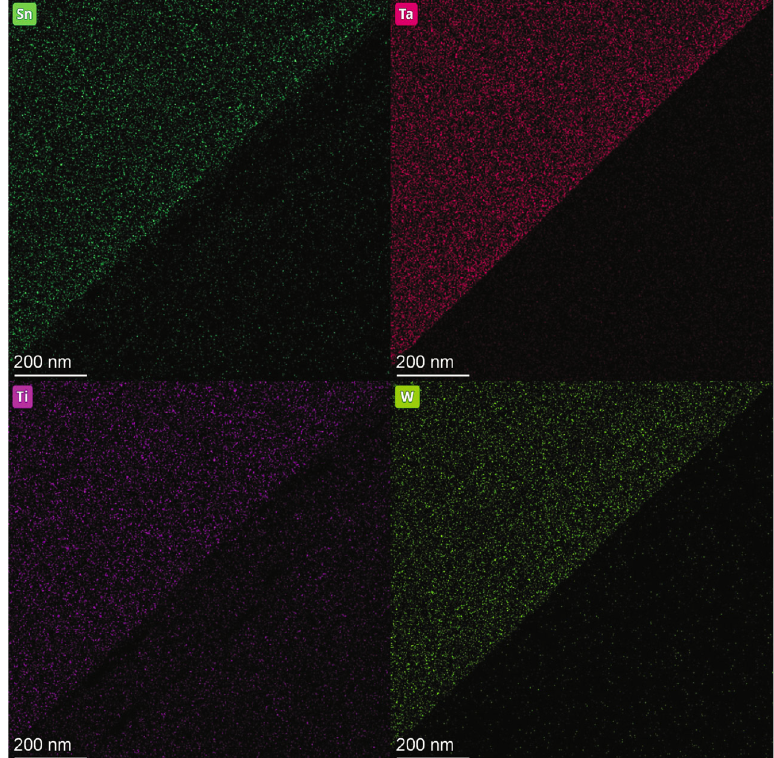
Figure 9: Sn, Ta, Ti, and W maps of a FIB-cut of the columbite-tantalite mineral. The location of this FIB-cut is the same as in Figure